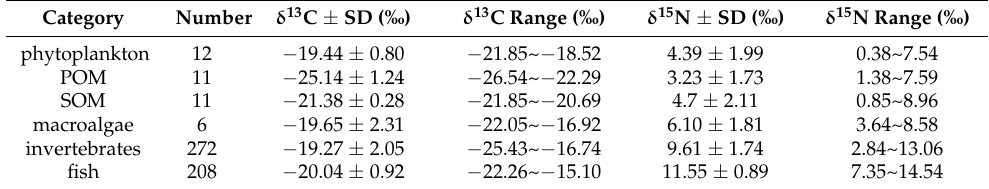
Table 2. Values of δ 13 C and δ 15 N for the potential carbon sources and